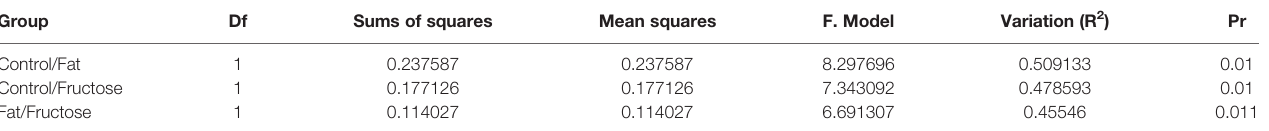
TABLE 2 | The result of the PERMANOVA